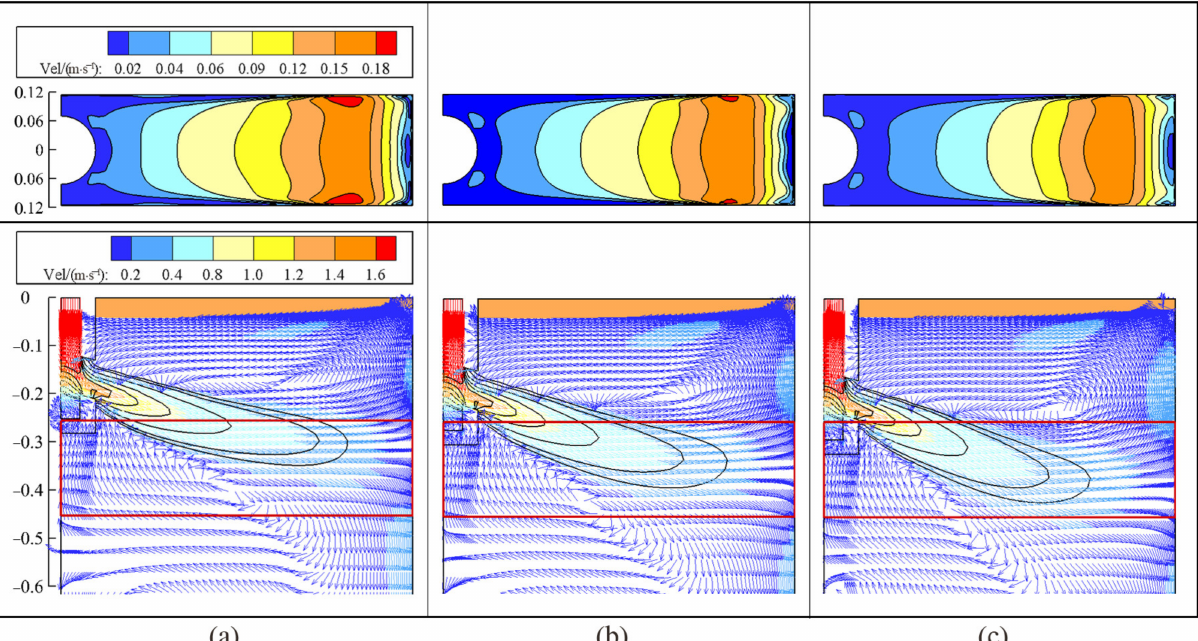
Figure 9. Molten steel flow characteristics in the mold with ruler EMBr under different SEN depths: ( a ) D SEN = 130 mm, ( b ) D SEN = 150 mm, and ( c ) D SEN = 170